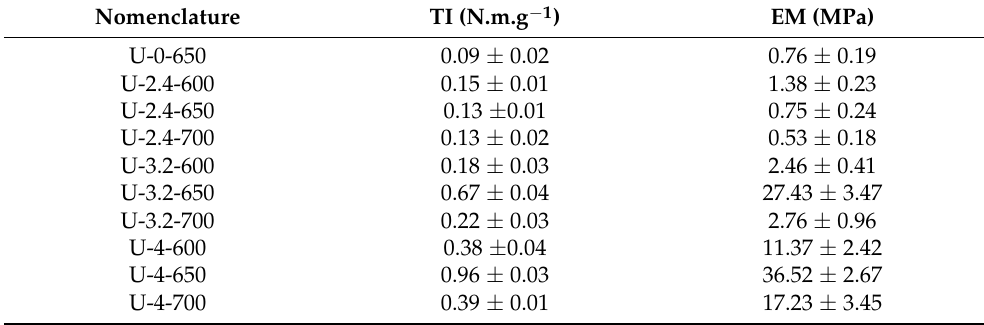
Figure 2. Strength vs. elongation when varying the aggregate amount of binder and calcination temperature. Table 3. Tensile index and elastic modulus values of ceramic papers prepared with natural